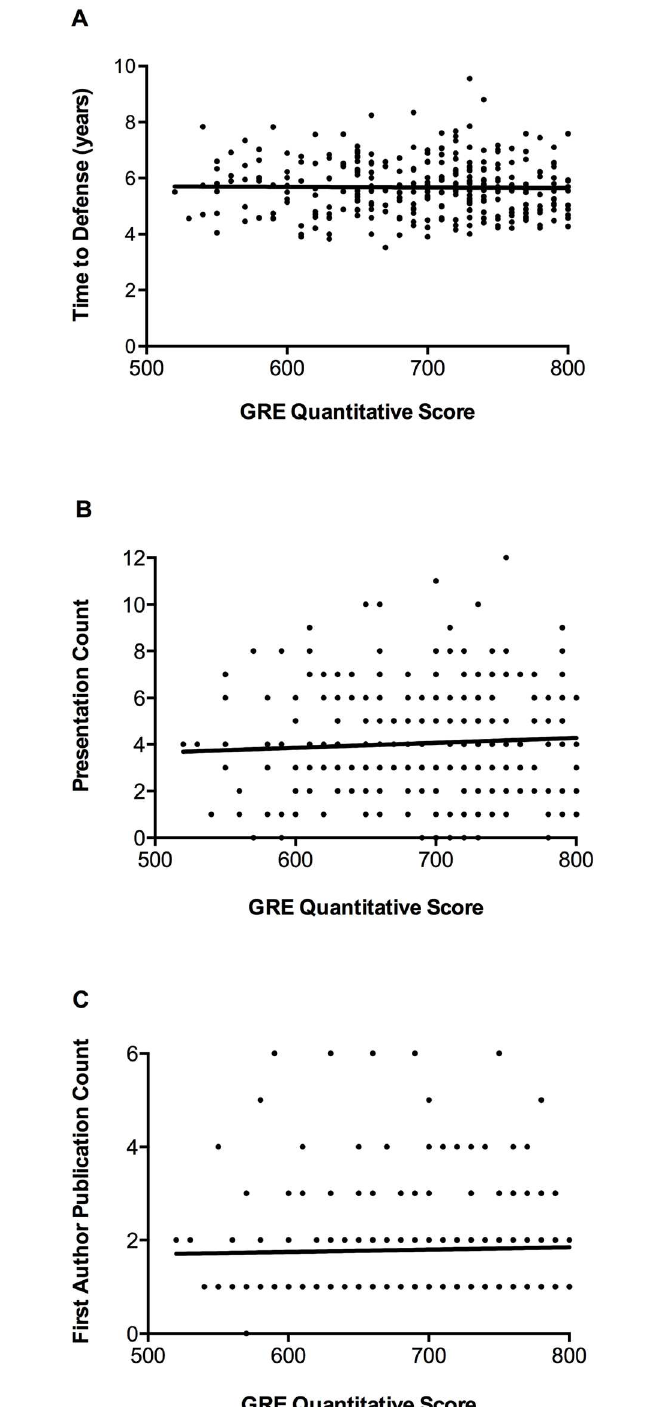
Fig 1. Correlations between GRE Quantitative scores and continuous measuresof student progress and productivity. Scatterplots of GRE Quantitative scores and (A) Time to Defense regression coefficient = 0.00, p = .83, R 2 = 0.00, (B) PresentationCount regression coefficient = 0.00, p = .32, R 2 = 0.00), and (C) First Author PublicationCount (regression coefficient = 0.00, p = .62, R 2 = 0.00). GRE Quantitative scores do not correlate with these measures of